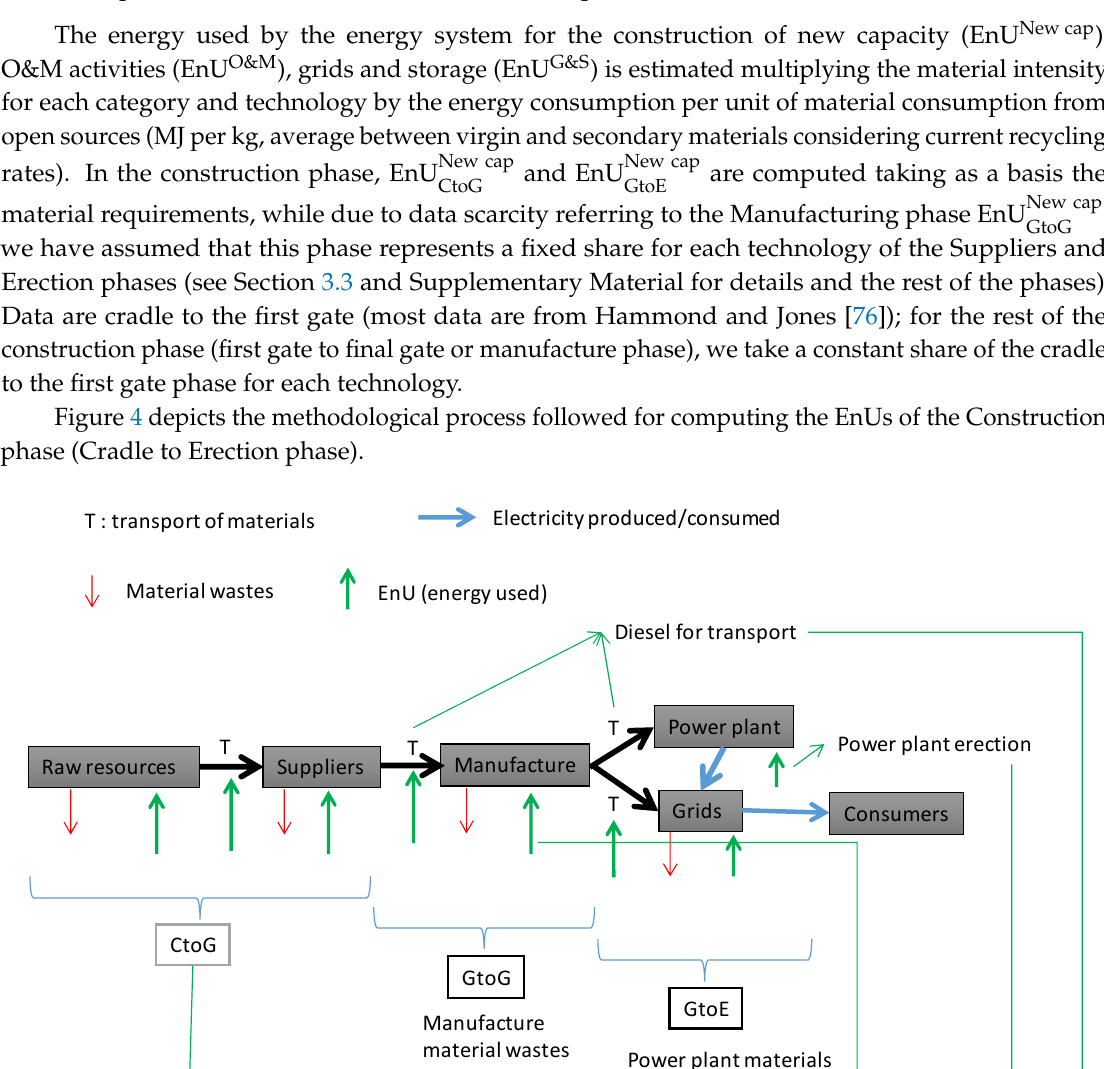
Figure 3. Conceptual representation of the energy inputs and output for power plants for variable renewable electricity generation and storage facilities. Black boxes represent energy investments considered at the EROI st phase, grey boxes the additional features incorporated into the EROI final , and the white boxes the indirect investments to compute the EROI ext . Adapted from [3], not to scale.